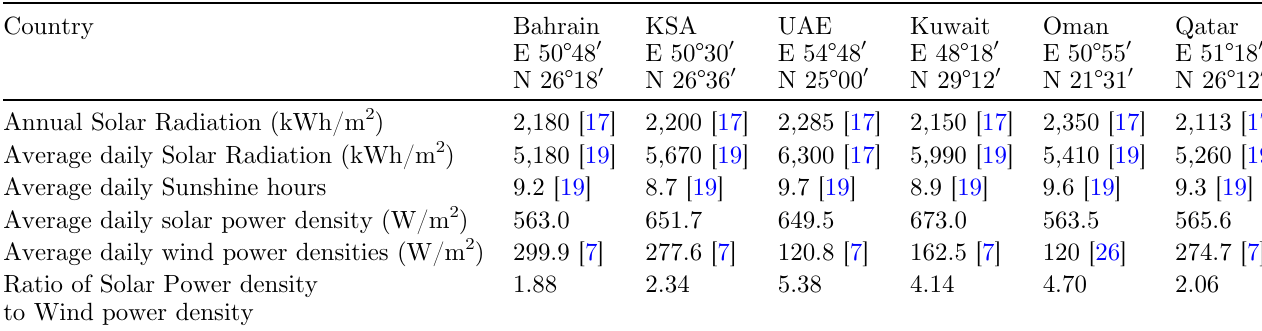
Table 1. Mean yearly solar radiation in GCCC [13]. Country